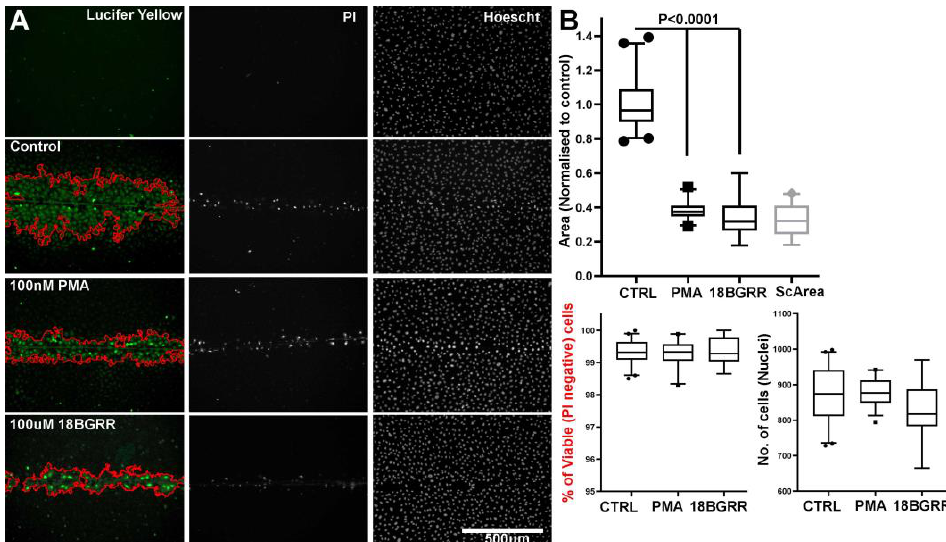
Figure 8. Inhibition of gap junctional coupling in HUVEC by PMA and 18 BGRR. ( A ) Left panels show LY signal in unscratched cells (top), vehicle control (DMSO) cells (second panel), PMA (100 nM; third panel) or 18BGRR (100 µ M; bottom panel) treated cells 15 min post-scratch wound. Middle panels show PI staining and right panels nuclear staining by Hoechst. Red lines in LY images show the area of LY spread determined by the automated macro Cut_Analyzer.ijm [48]. ( B ) (top) the quantification of LY dye spread (normalised to the control) in control ( n = 40 measurements), PMA (100 nM, n = 34) and 18GRR (100 µ M, n = 17). Right (bottom) shows the cell count/field of view and cell viability (% of PI+ cells). The data are pooled from two independent experiments and are identical to the results obtained from a further two independent experiments (not shown). p < 0.0001 comparison to control, ANOVA, GraphPad Prism. Data are expressed as in Figure 7. Scale bar is 500 µ